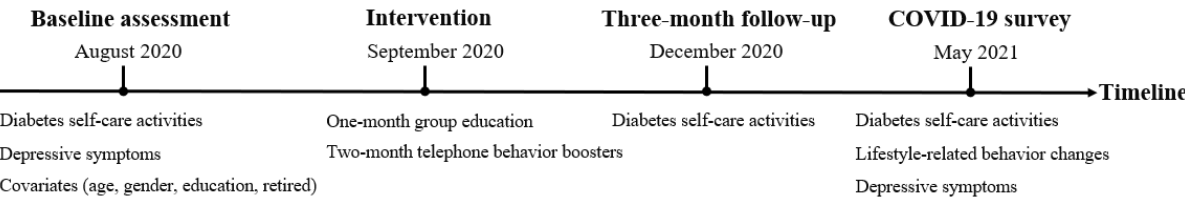
Figure 2. Measures across study period.